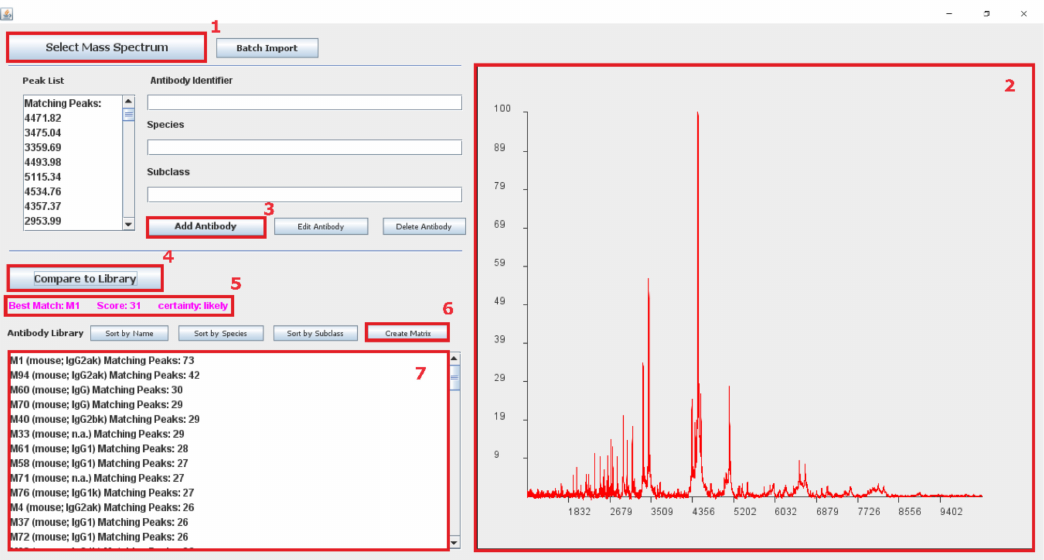
Figure 10. Screenshot of the software tool “ABID” for creating databases for antibody fingerprints and searching the database for matches. ( 1 ) “Select Mass Spectrum” allows the user to upload an antibody fingerprint spectrum (as ASCII file) into the software. A peak picking algorithm is automatically detecting the peaks in the spectrum, creating a list mass of antibody peptide peaks. The uploaded spectrum and detected peaks are shown in Window ( 2 ). The user can create a new entry to the database by filling in an antibody identifier, species, and antibody subclass and subsequently adding it by pressing ( 3 ): “Add Antibody”. The spectrum can be compared to all library entries by pressing ( 4 ): “Compare to Library”. The best match is shown in Window ( 5 ) with a given certainty based on a calculated score. Button ( 6 ), “Create Matrix”, creates a correlation matrix, as shown in Figure 5, correlating all peptide mass lists from the library with each other. All library entries are sorted by the number of matching peaks ( ± value of predefined resolution) with the uploaded spectrum and shown in Window ( 7